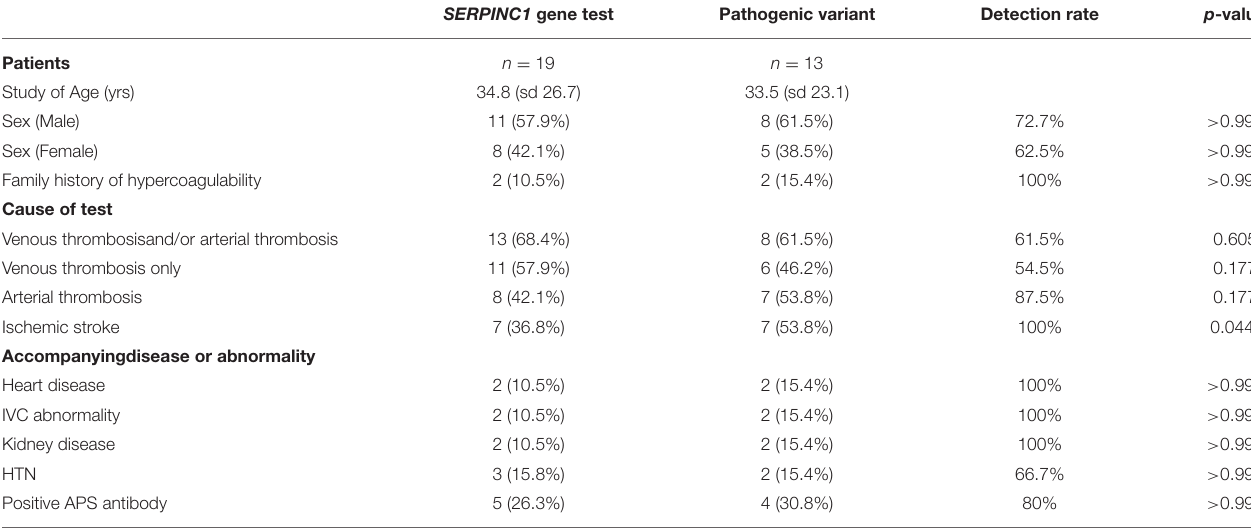
TABLE 1 | Analysis of antithrombin III deficiency patients with SERPINC1 gene test and pathogenic variant detection rate. SERPINC1 gene